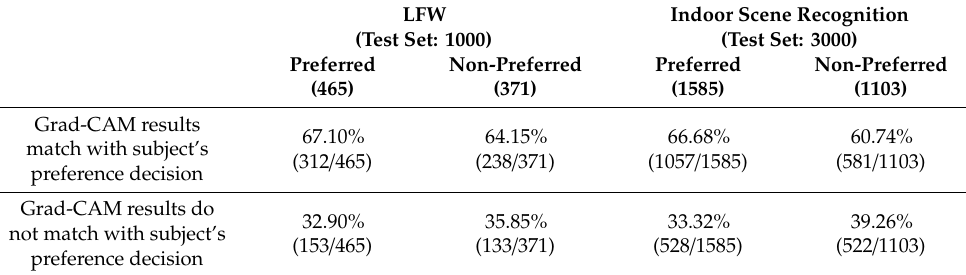
Figure 9. Visual expressions applying Grad-CAM for user preference–classification results with LFW: ( a ) sample heat maps for the results in preferred data, and ( b ) sample heat maps for the results in non-preferred data. Table 5. Consistency analysis of Grad-CAM results with the subject’s preference decision with the LFW and Indoor Scene Recognition datasets.